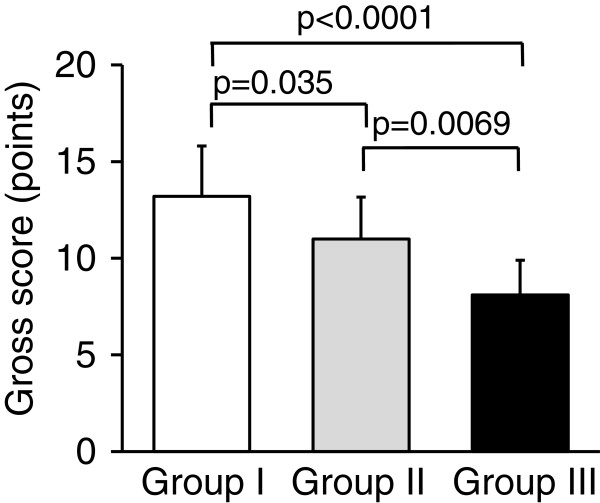
Concerning the Wayne’s score on gross obsevation at 12 weeks, the ANOVA showed a significant difference among the 3 groups (p < 0.0001). The post-hoc test indicated that Group I was significantly greater than Groups II and III, while Group II was significantly greater than Group III.